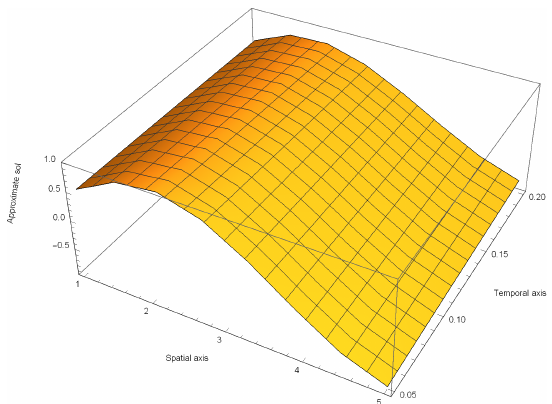
Figure 3. Estimated solution for coupled Burger Equation’s t ∈ [ 0, 1